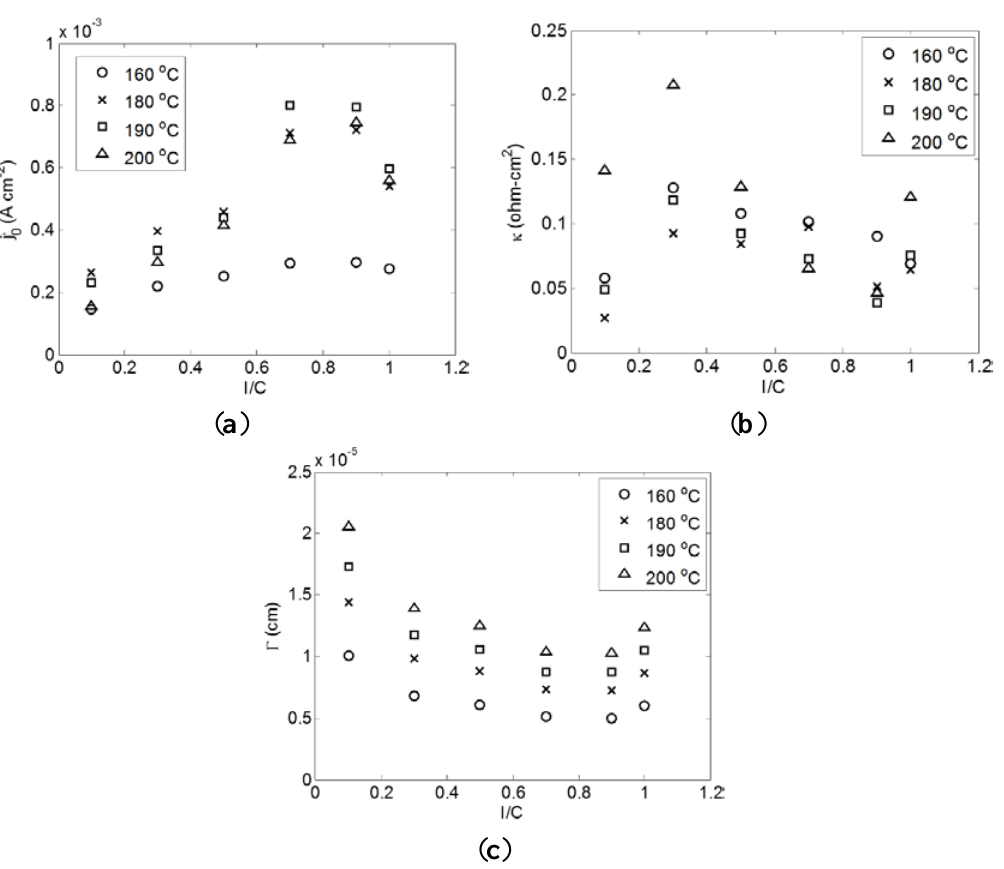
j ′ , ( b ) represents the area specific 0,c